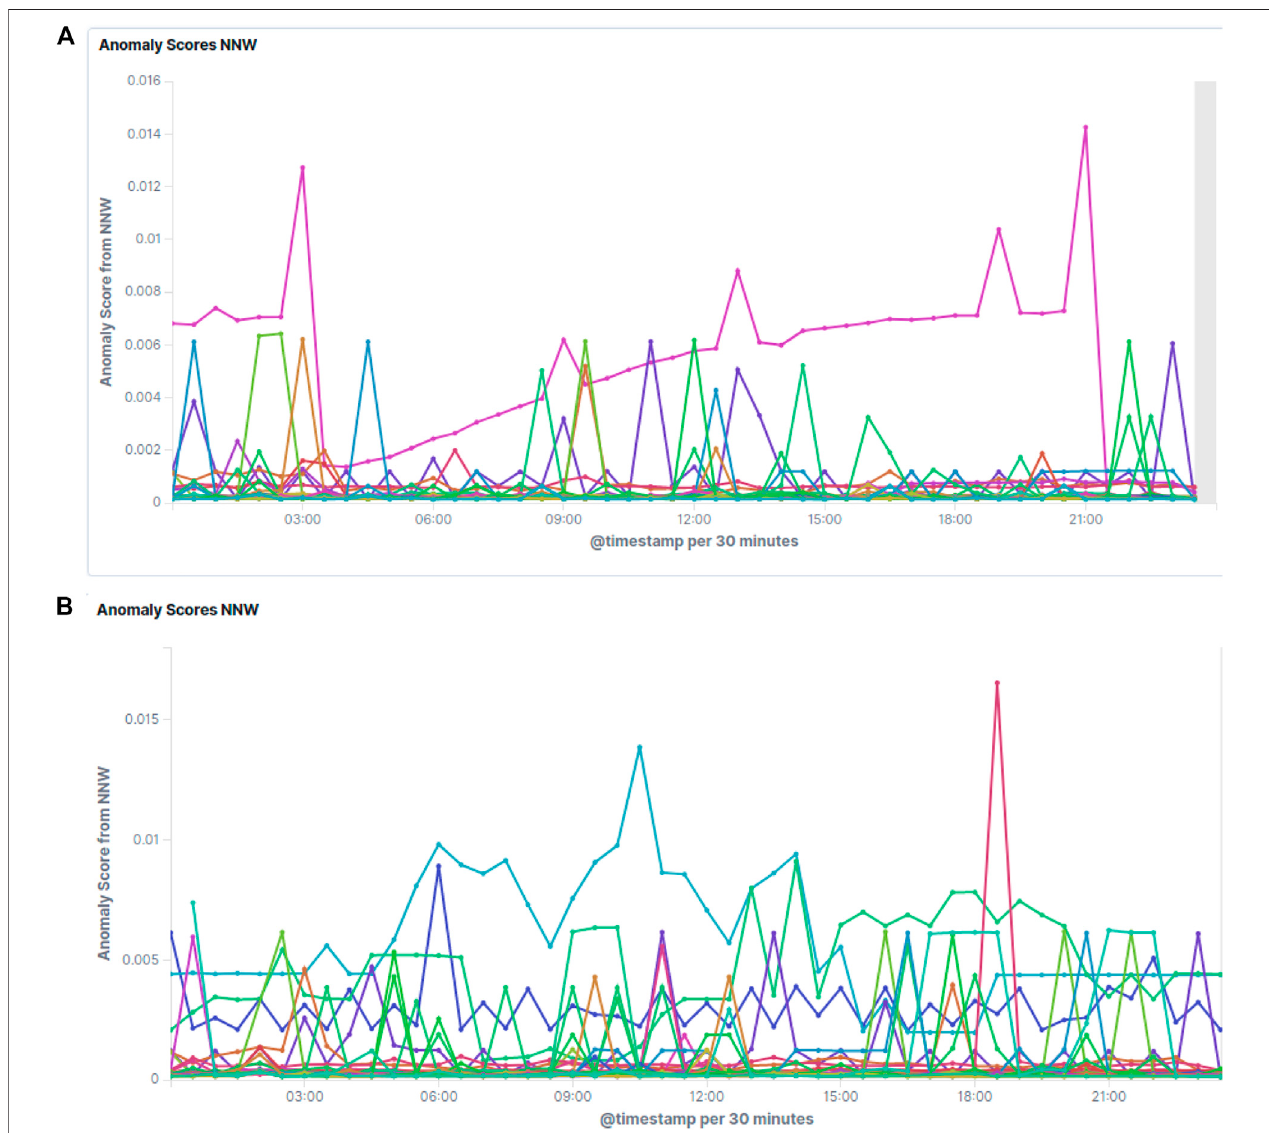
FIGURE5| ScreenshotsoftherawanomalyscoresasestimatedbytheLSTMnetwork.EachlinecorrespondstoadifferentElasticsearchcluster.Lowervaluesare better, meaning that the prediction matches the actual value better. Clusters with scores sticking out above the others over longer times of periods or with increasing scoresovertimeneedattention. Figure5A normalconditionswithsomenoiseandoneclusterwithanissuebuildingup,and Figure5B atypicalfulldayshowingseveral issues to be